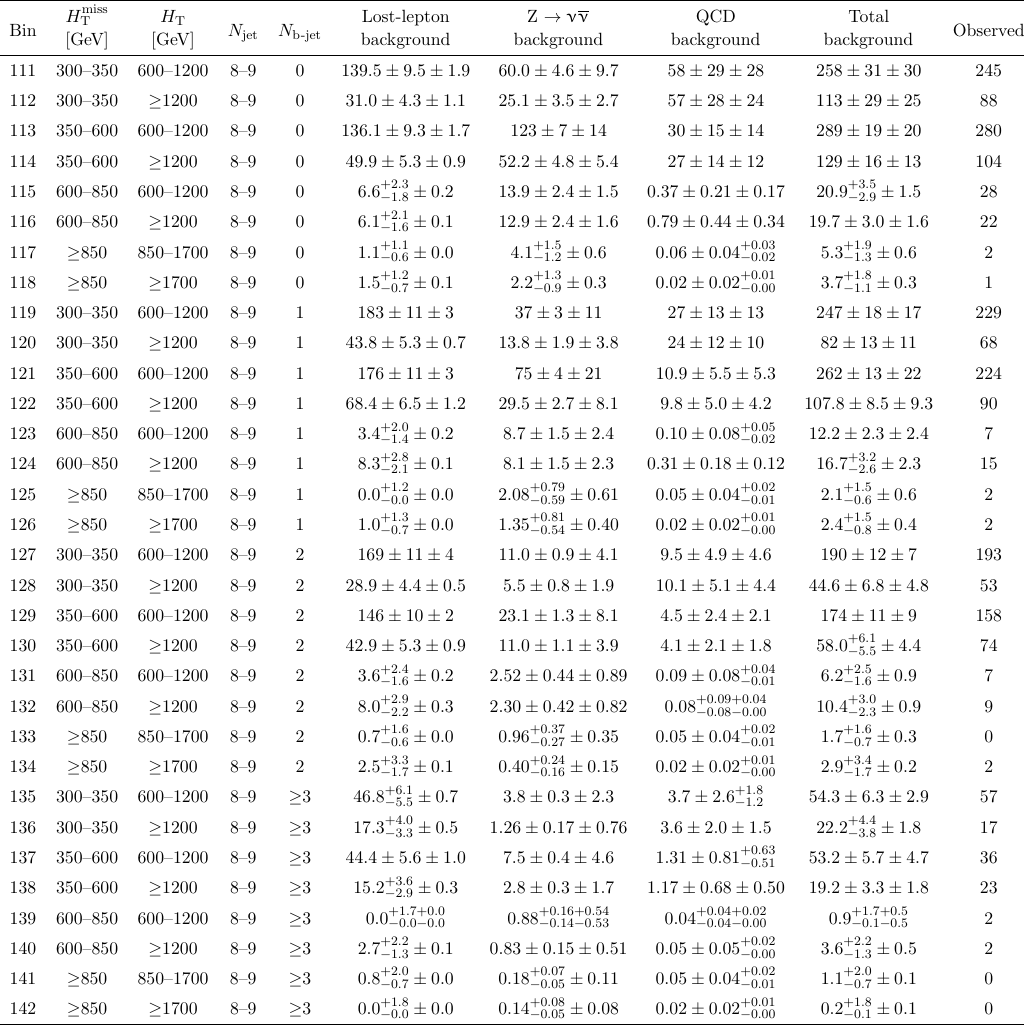
Table 6 . Observed number of events and pre-(cid:12)t background predictions in the 8 (cid:20) N bins. For the background predictions, the (cid:12)rst uncertainty is statistical and the second